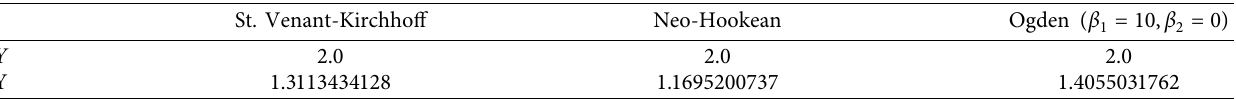
Figure 21: Unknown and known confguration of a 2D nonlinear truss structure. Te three diferent hyperelastic material laws are compared: St. Venant-Kirchhof, Neo-Hookean, Ogden. Table 6: Unknown reference confguration and desired aim confguration for various hyperelastic material